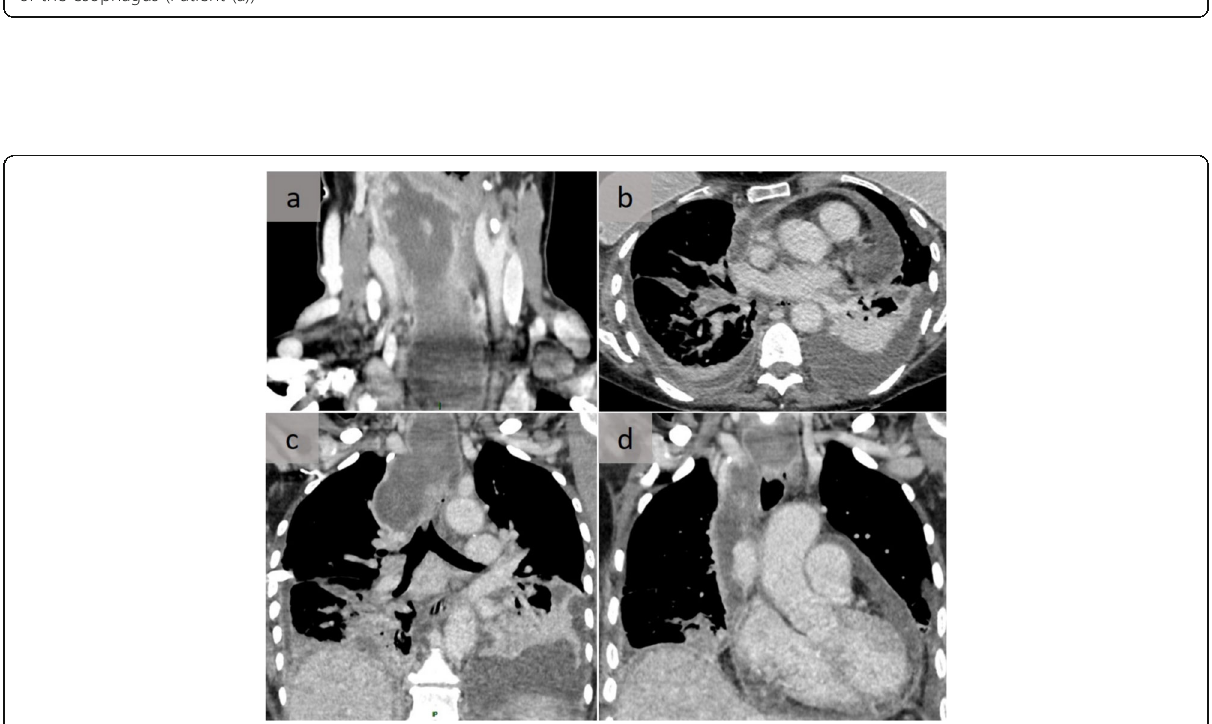
Fig. 5 Infectious mediastinitis. Acute, descending, necrotizing mediastinitis related to an oropharyngeal infection treated with non-steroidal anti- inflammatory drugs and antibiotics. Latero-pharyngeal ( a ) and median and right-sided mediastinum are ( c ) hypodense, with peripheral enhancement collections in coronal reformatting and bilateral pleural effusion and passive atelectasis ( c ); pleural effusion with parietal pleural enhancement related to bilateral empyema and pericardial effusion, and parietal pericardial enhancement related to purulent pericardial effusion on axial ( b ) and coronal views ( d